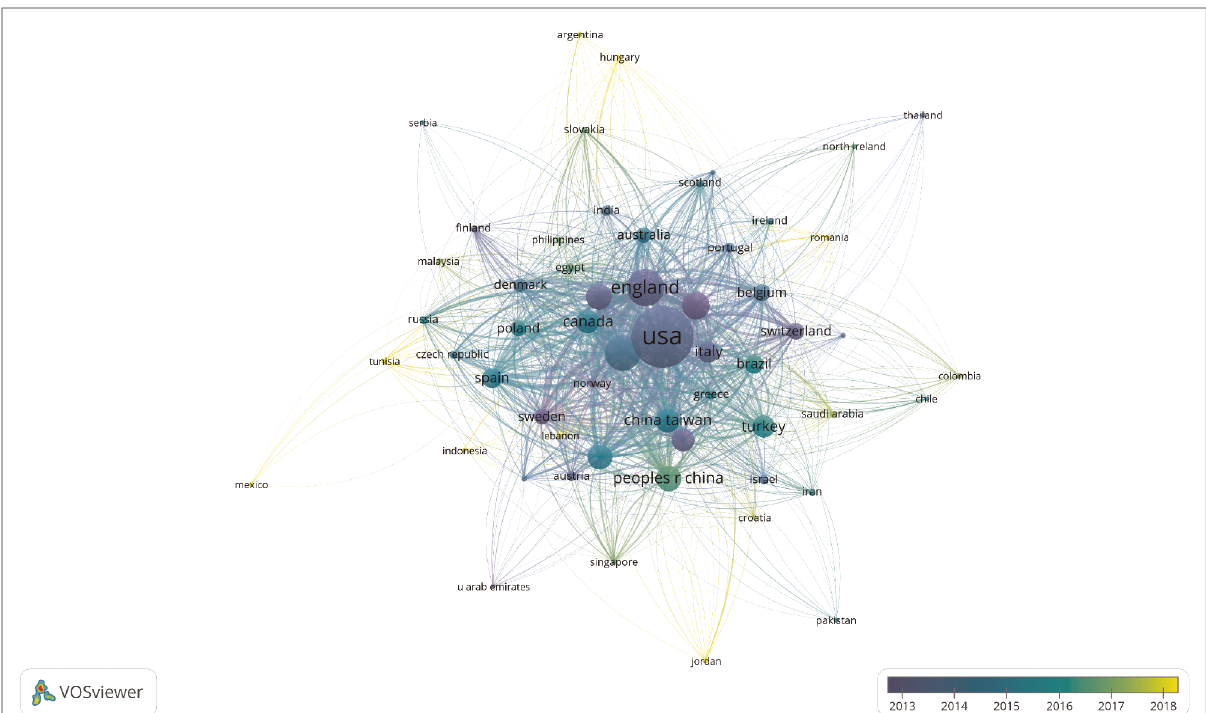
FIGURE 4 Network map illustrating international research collaborations between countries in original human studies on overactive bladder. Colors represent the date of